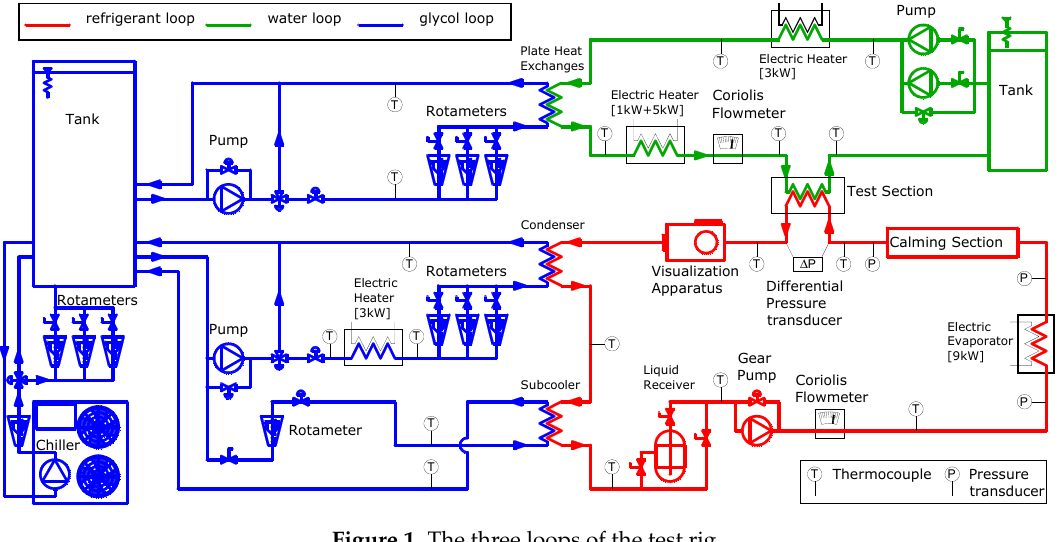
Figure 1. The three loops of the test rig.